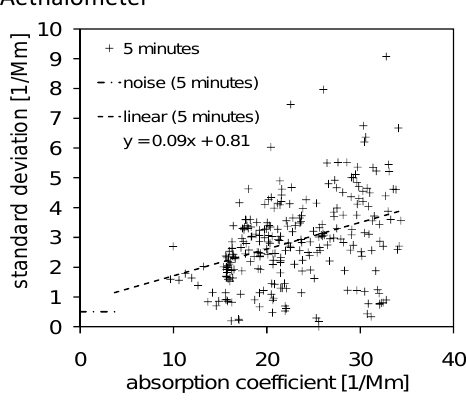
Fig. 9. EUSAAR2007: Unit to unit variability (standard deviation of several instruments) vs. absorption coefficient for (a) MAAP (seven instruments), (b) PSAP (six 3 λ -PSAP, green) and (c) Aethalometer (four 7 λ -Aethalometers, 660nm). PSAP and MAAP data are shown for the highest time resolution of one minute and for an averaging time of ten minutes. Aethalometer data are shown for an averaging time of 5min. The noise level is indicated as horizontal